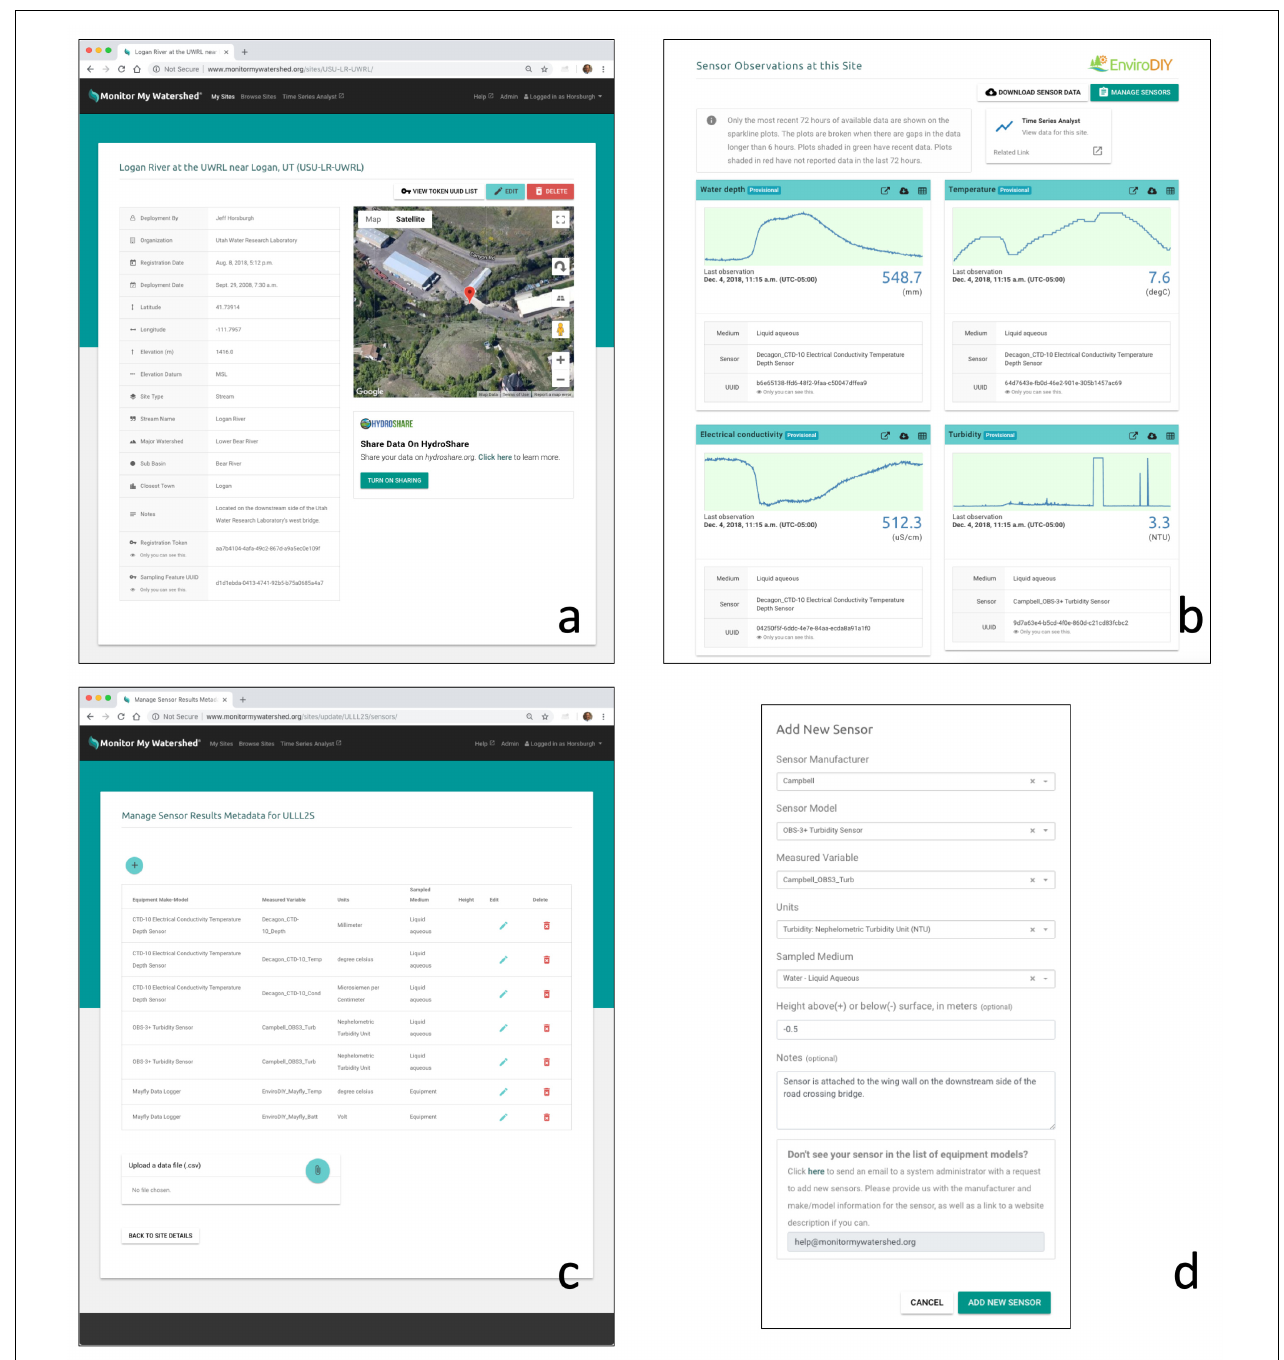
FIGURE 4 | Detailed views of the Site Details page of the Data Sharing Portal. (a) Detailed metadata for a registered site. (b) Sparkline visualizations of data for each of the variables measured at a site. (c) Interface for managing sensors and measured variables at a site. (d) Window for adding or editing a sensor for a site.